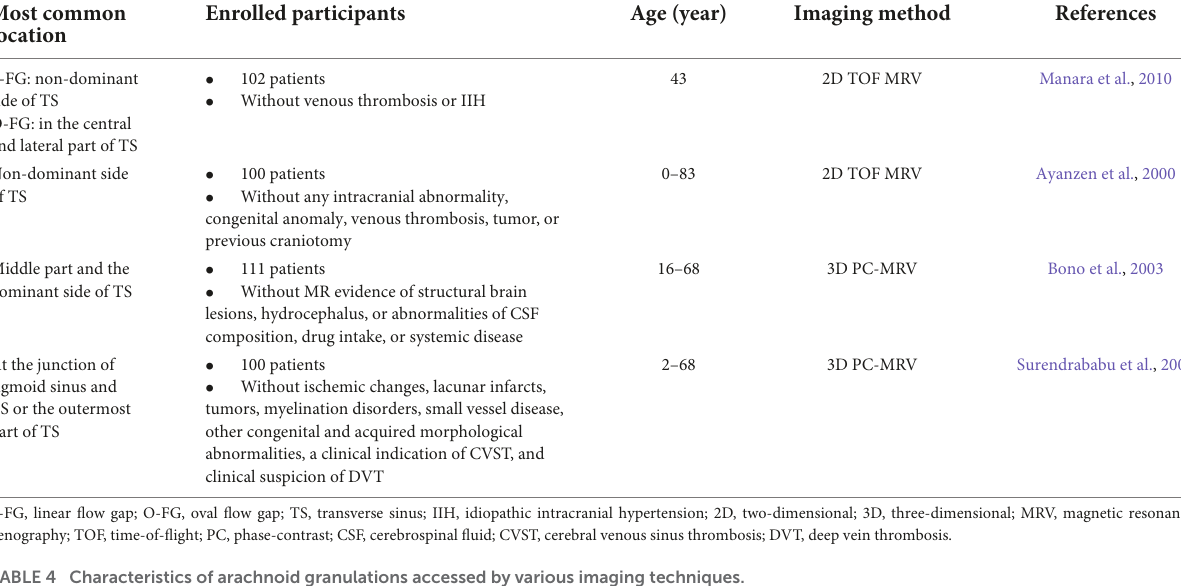
TABLE 4 Characteristics of arachnoid granulations accessed by various imaging techniques. Imaging